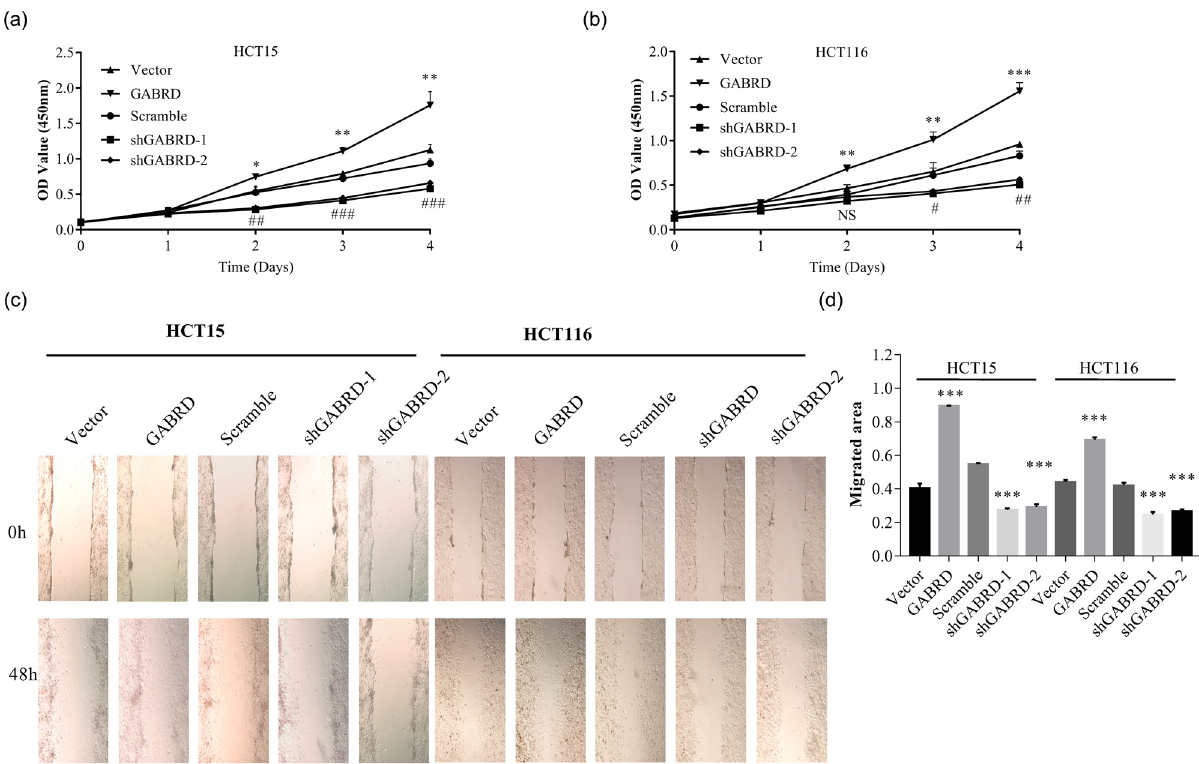
Figure 4: GABRD promoted CRC cell proliferation and migration. HCT15 and HCT116 cells were transduced with vector, GABRD, scramble shRNA, or shGABRDs, and underwent CCK - 8 cell proliferation assay and monolayer wound healing assay. Overexpression of GABRD promoted while knock - down of GABRD impeded cell proliferation ( a and b ) and migration ( c and d ) of these cells. Abbreviations: CCK - 8, cell counting kit - 8; CRC, colorectal cancer; GABRD, gamma - aminobutyric acid type A receptor subunit delta; NS, not signi fi cant. * p < 0.05, ** p < 0.01, *** p < 0.001; #, ##, and ### represent p < 0.05, p < 0.01, and p < 0.001, respectively, for comparisons between scramble and shGABRD - transduced cells in ( a and b ) . Data representative of three replicated experiments are